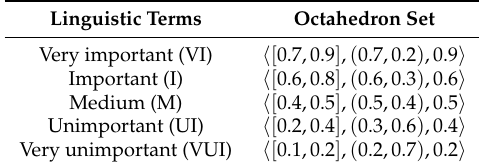
Table 1. Linguistic term for rating of